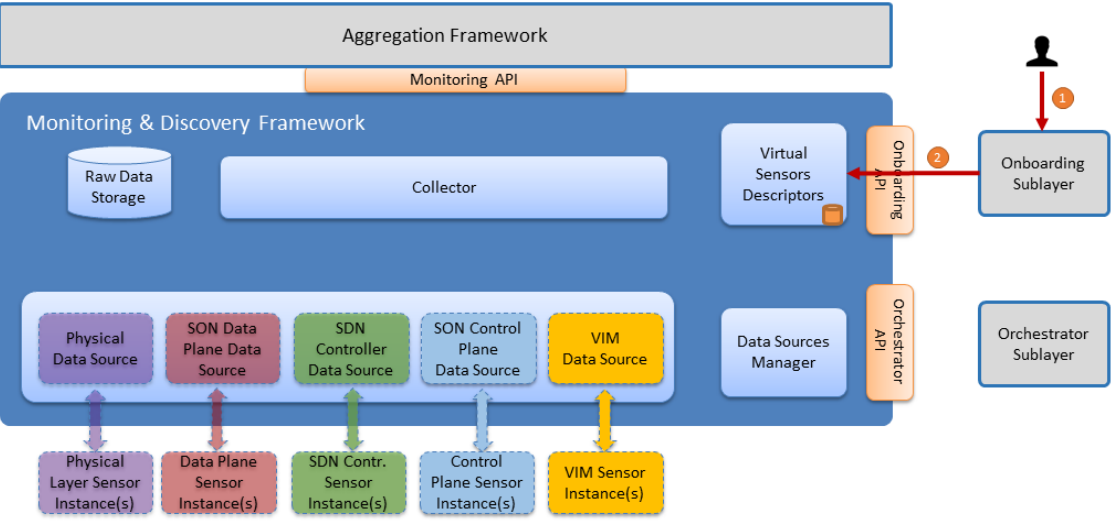
Table 5. Sensor Onboarding Workflow Steps.